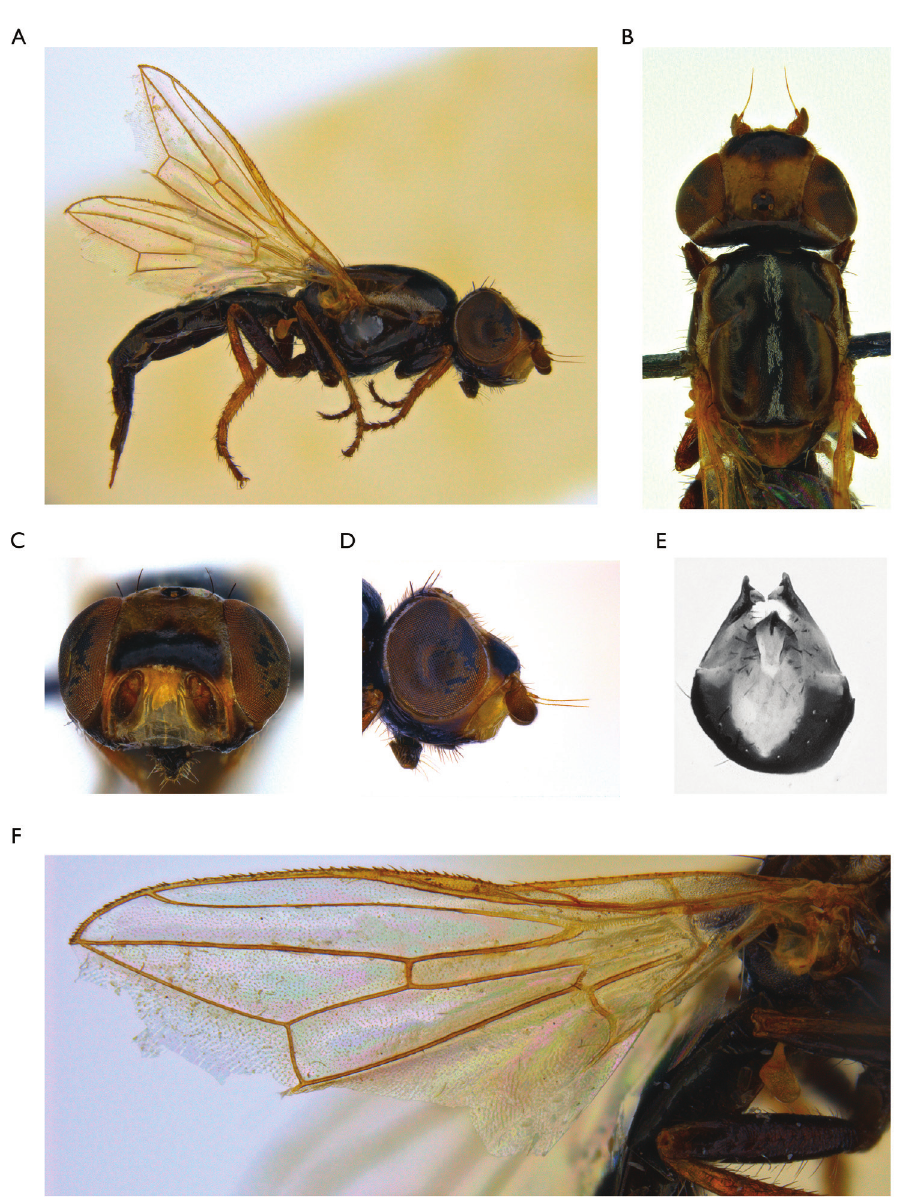
Figure 2. Timia shatalkini Galinskaya, sp. n., paratype female; A habitus, lateral view B head and thorax, dorsal view C head, anterior view D head, lateral view E epandrium of male, dorsal view F wing. Setae . Four small orbital setae (dorsal orbital seta little longer than other ones), one divergent ocellar seta, one divergent postocellar seta, one long convergent medial vertical seta, five divergent postocular setae, one short paravertical seta, and one